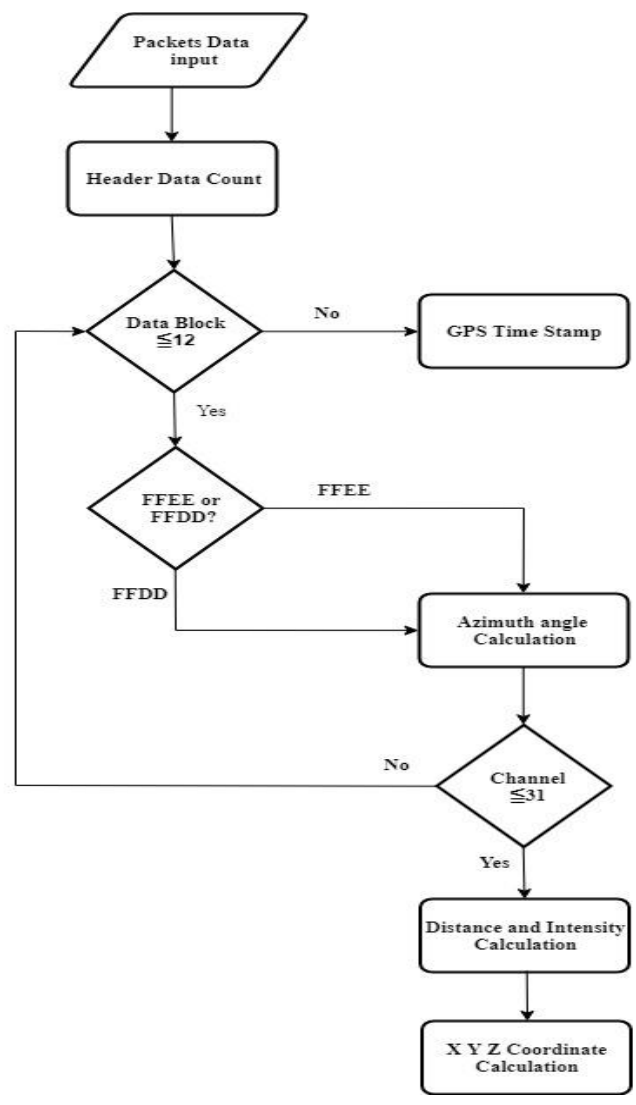
Figure 2. LiDAR decoding flow chart.